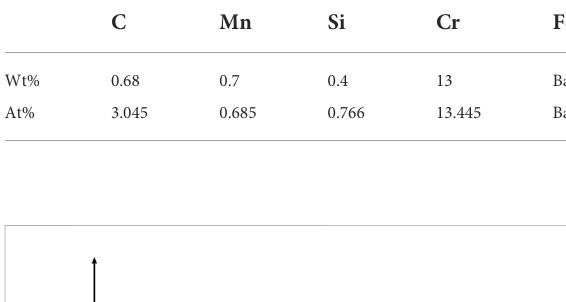
TABLE 1 Nominal composition of the investigated material.